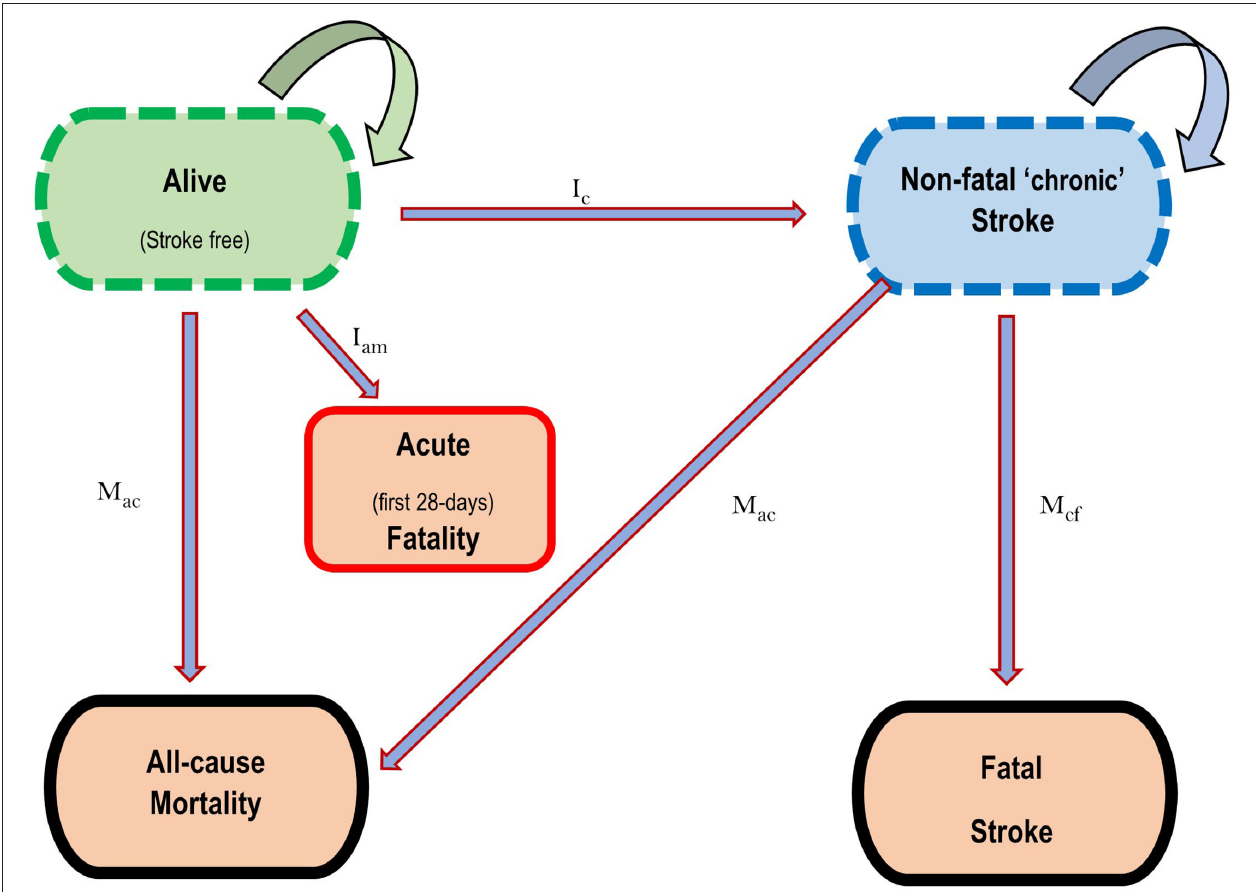
FIGURE 1 | State transition diagram depicting the five health states for the Stroke Markov model. I c = Incidence of Stroke in the first year, I an = Case fatality in the first 28 days following incident CVD, M cf = Case fatality in the first year for survivors of first 28-days Stroke mortality, M ac = Mortality from all causes in that year. Straight arrows represent directions of movement of proportions of the population between health states, while circular arrows represent the probability of remaining in each health state. Death is an absorbing